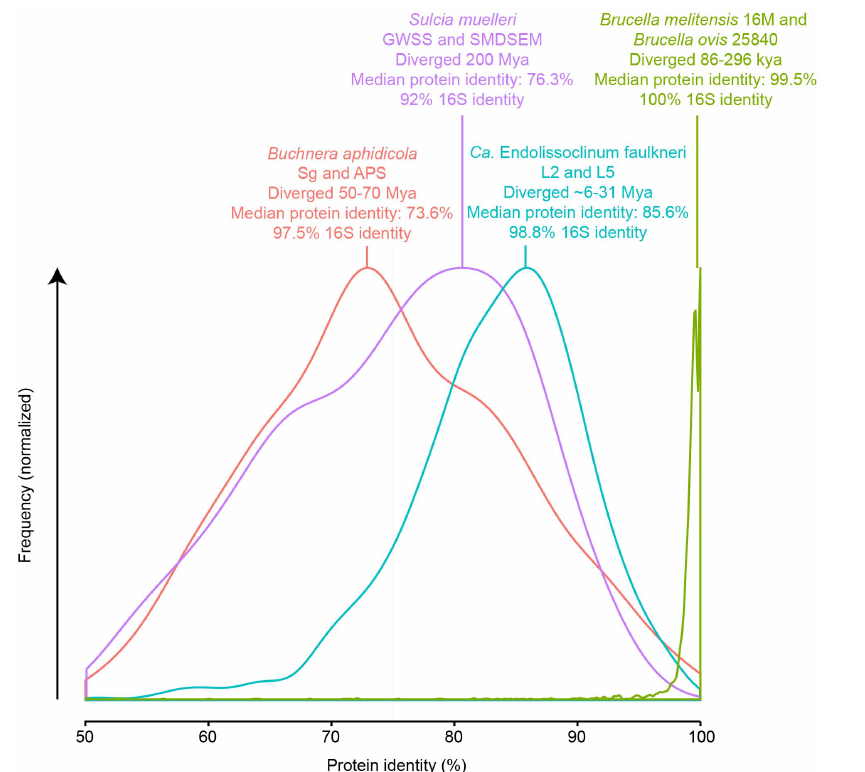
Figure 6. Sequence drift in the genomes of Ca. E. faulkneri is on the order of that seen in pairs of endosymbionts known to have diverged tens of millions of years ago. By comparison, a pair of intracellular pathogens that are thought to have diverged before the domestication of their respective hosts exhibits far less sequence drift.